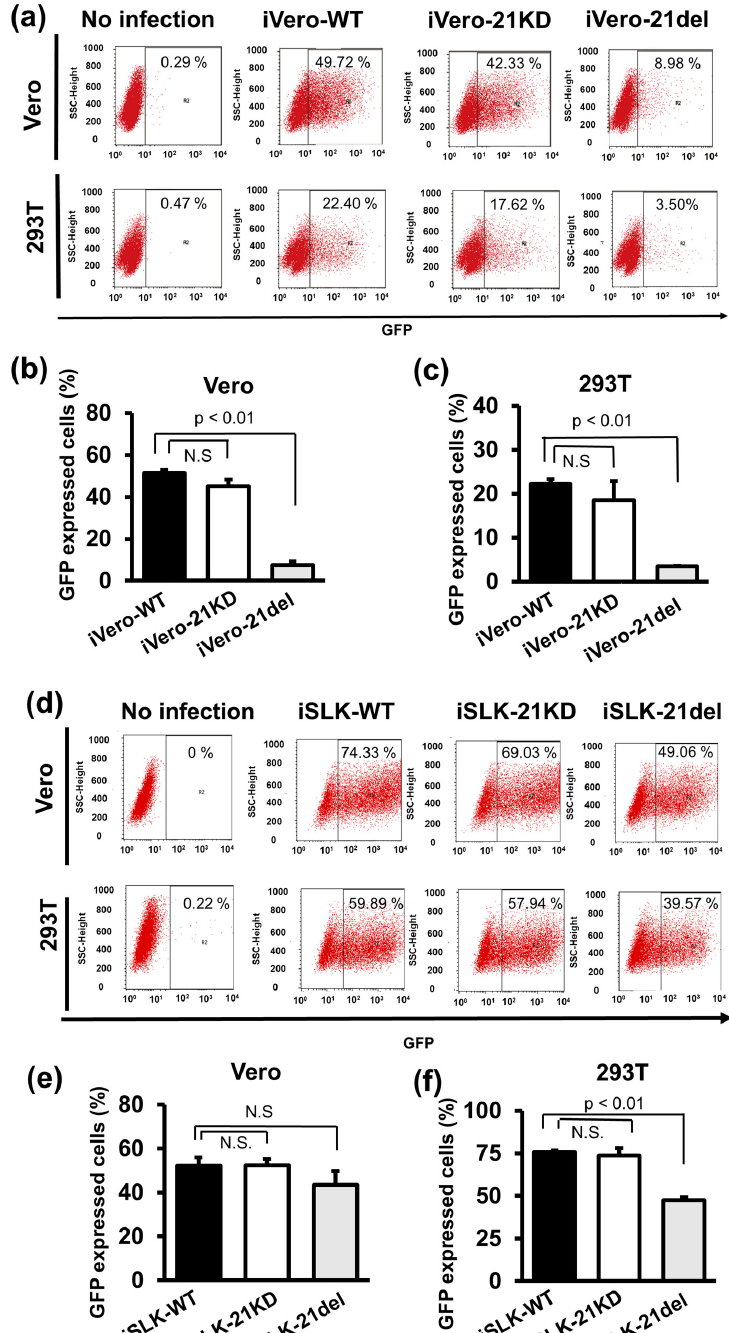
Figure 5. ORF21 is involved in infectious virus production. ( a – c ) Recombinant BAC16-harboring iVero cells (iVero-WT, iVero-21KD, and iVero-21del) or ( d – f ) iSLK cells (iSLK-WT, iSLK-21KD, and iSLK-21del) were treated for 96 h with Dox and NaB to produce recombinant KSHV, and the culture supernatants were harvested. The progeny viral particles were precipitated with ultracentrifugation, and partially purified viral particles (at approximately 10 5 viral genome copies/cell) were used to infect fresh Vero cells ( b , e ) and 293T cells ( c , f ). The GFP-positive cells (i.e., infected cells) were counted by flow cytometry 48 h post-infection to determine the infectivity of the produced recombinant viruses. N.S., not significant. p < 0.01 indicates a statistically significant difference compared with the iVero/iSLK-WT